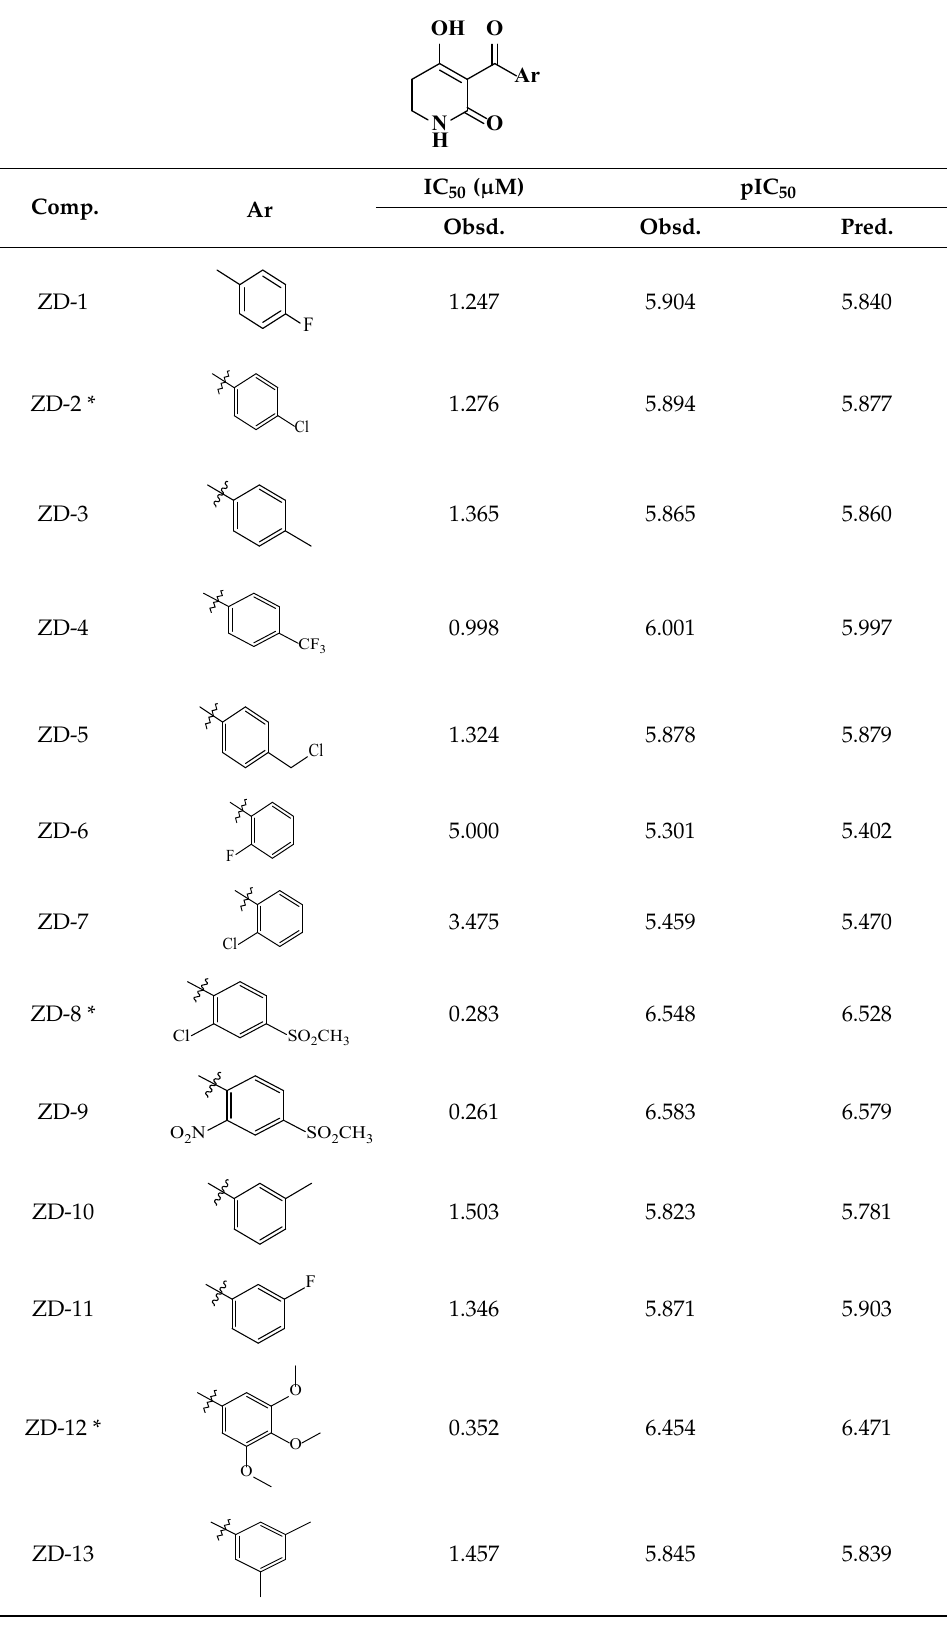
Table 7. Pyridine derivatives used for the Topomer CoMFA analysis.